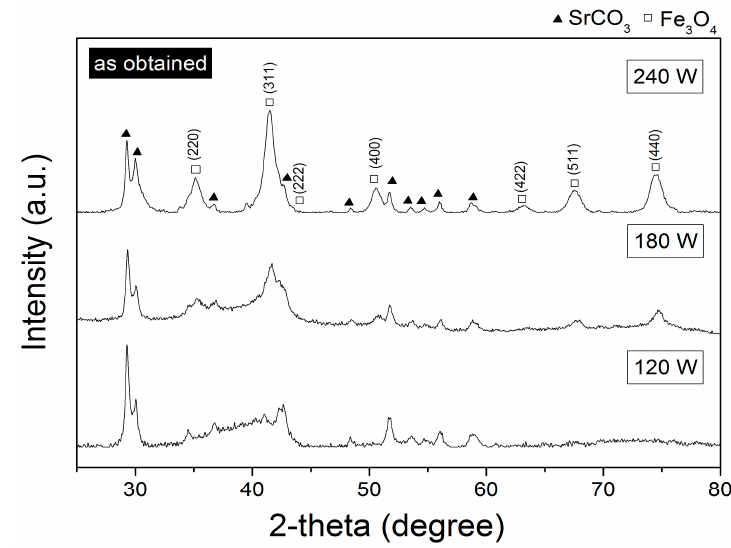
Figure 2. X-ray diffraction patterns of powders “as obtained” with sonication output power of 120, 180, and 240 W over 3 h.